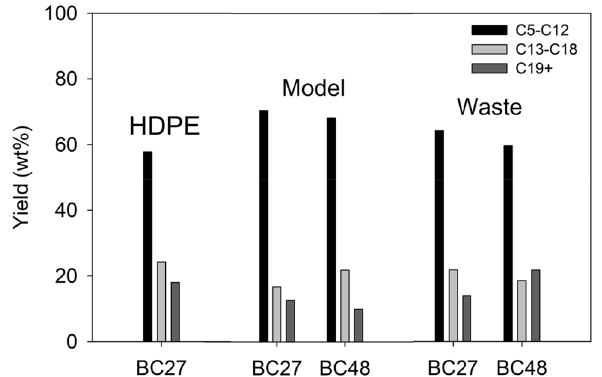
Fig. 13 Results of the stability test of BC27 and BC48 catalysts for the catalytic hydroconversion reaction of model plastic mixture. 500 ml autoclave reactor, 20 bar initial cold hydrogen pressure, 60 min residence time, and 20:1 feed-to-catalyst ratio (by